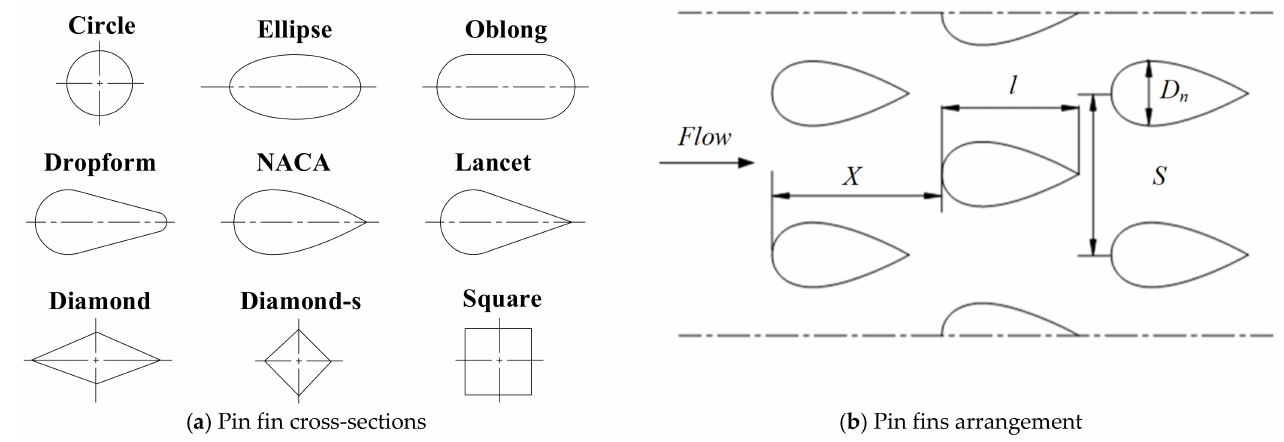
Figure 2. Pin fin